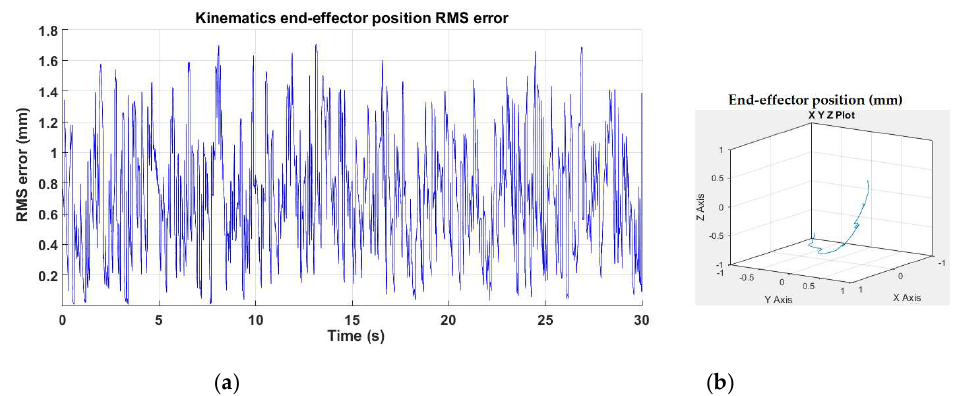
Figure 20. Sensor fault condition: ( a ) kinematics end-effector position RMS error and ( b ) end effector position in the XYZ plot.